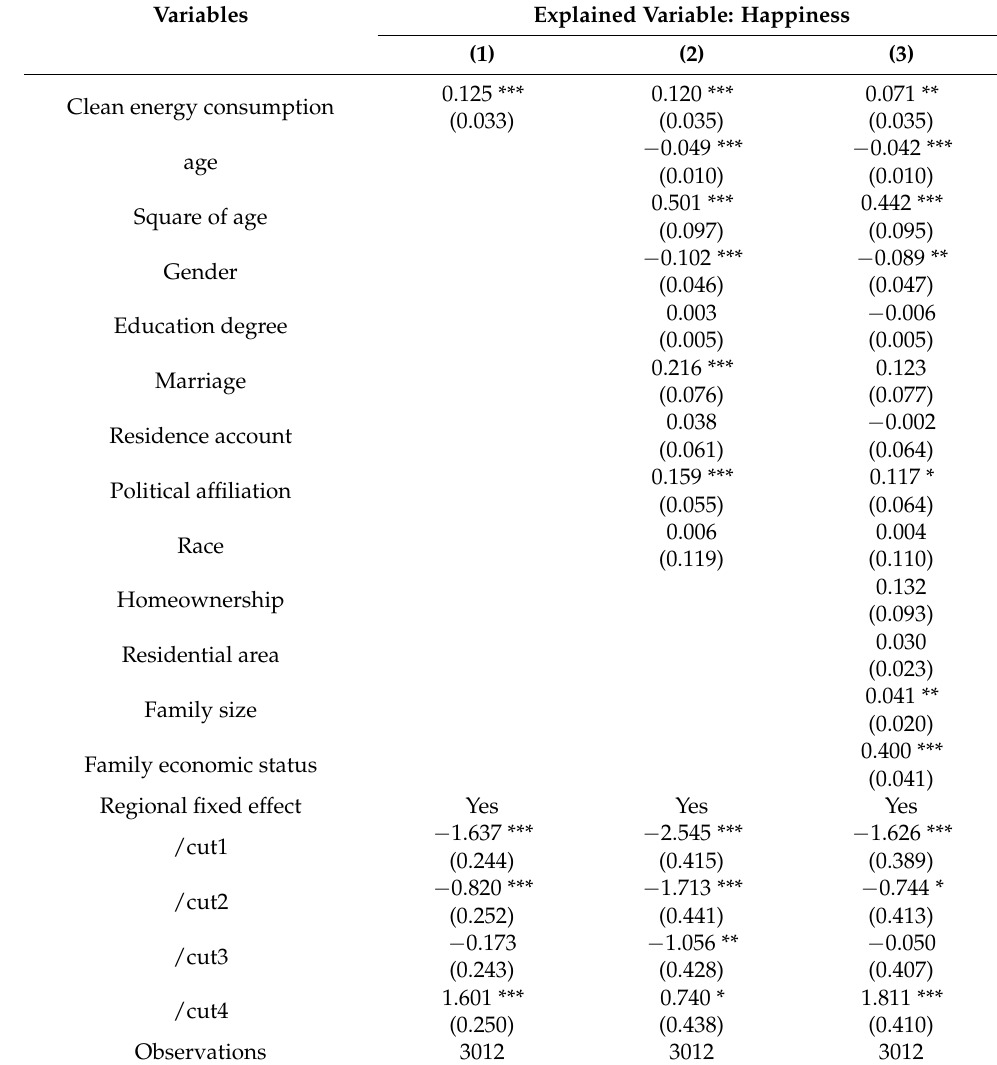
Table 4. Benchmark